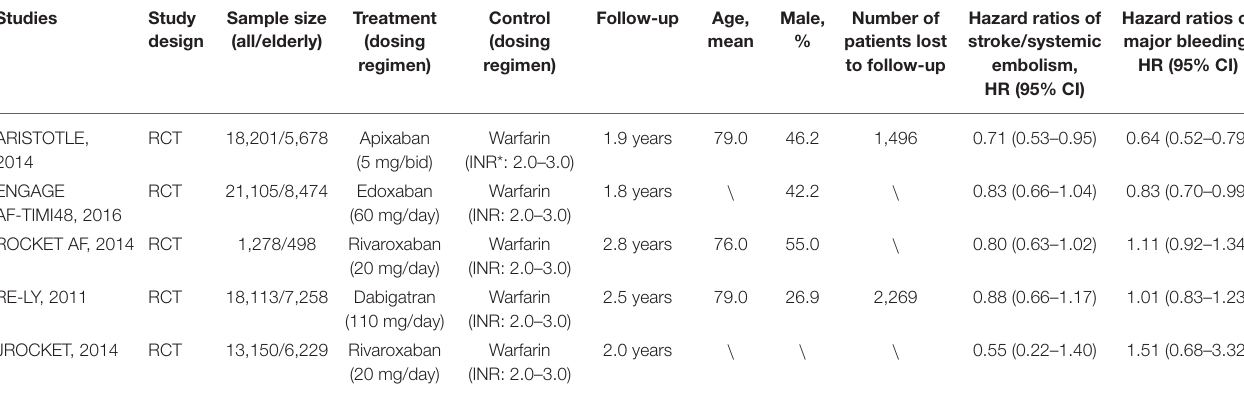
TABLE 1 | Summary of RCTs included in the network